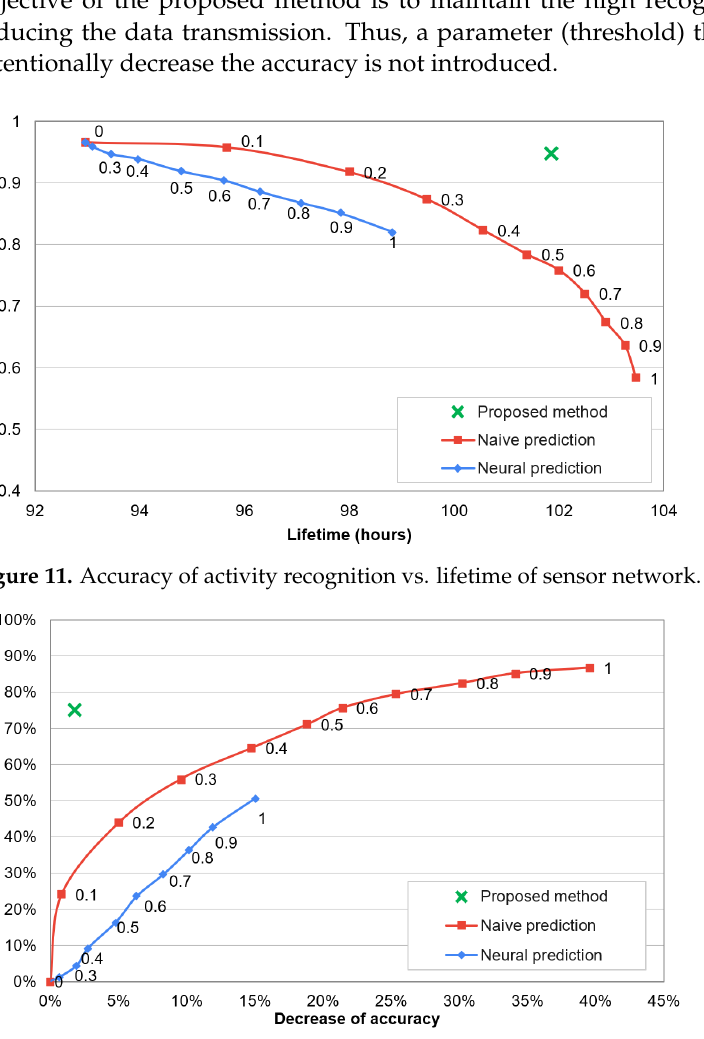
Figure 12. Reduction of transmissions vs. accuracy decrease of activity